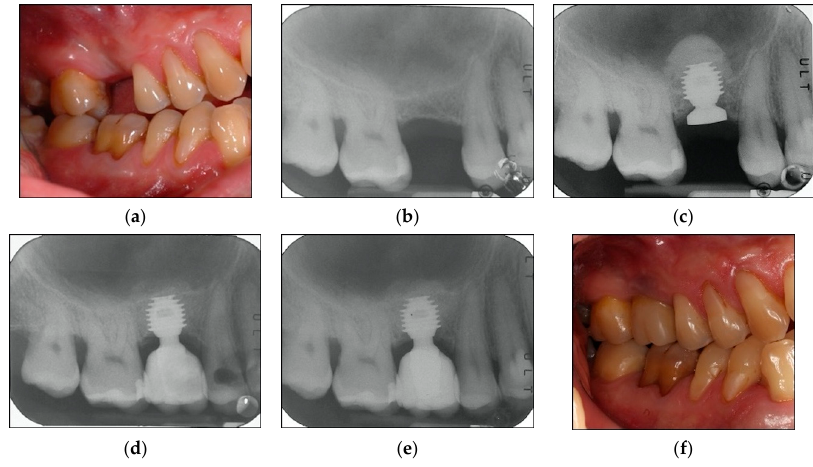
Figure 2 . ( a – f ) . Clinical case: Single implant placed in 1.6 site. ( a ) Clinical photograph before implant placement, missing first molar. ( b ) Pre-operative radiograph before implant placement in site 1.6. See minimal bone in implant site. ( c ) Radiograph obtained at implant placement. See short implant with sinus lift temporary abutment designed to prevent displacement of the implant into the sinus, also see augmented sinus floor. ( d ) Radiograph obtained at time of loading. See augmented sinus floor, also see the radiolucent area in the crown of the second bicuspid, which was a lost restoration. ( e ) Radiograph obtained at three-year follow-up. See stable bone levels, also see the replaced restoration in the crown of the second bicuspid. ( f ) Clinical photograph at three-year follow-up. See stable clinical conditions.